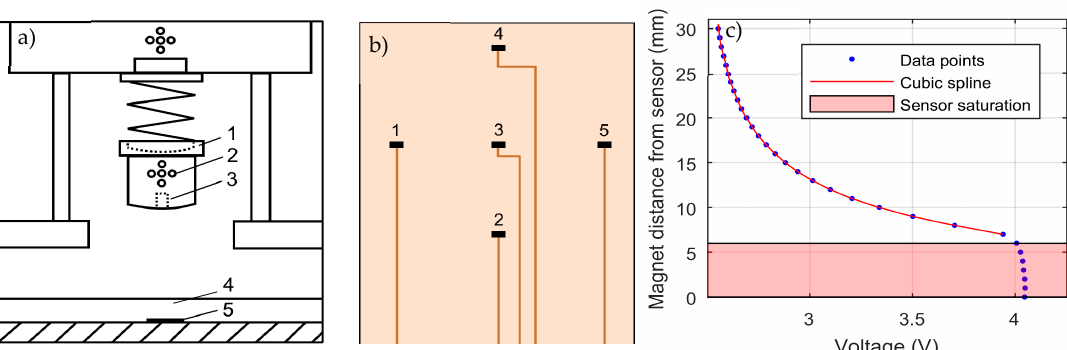
Figure 2. ( a ) AAA test set up; 1. Nylon test foot; 2. GOM markers; 3. Embedded magnet; 4.